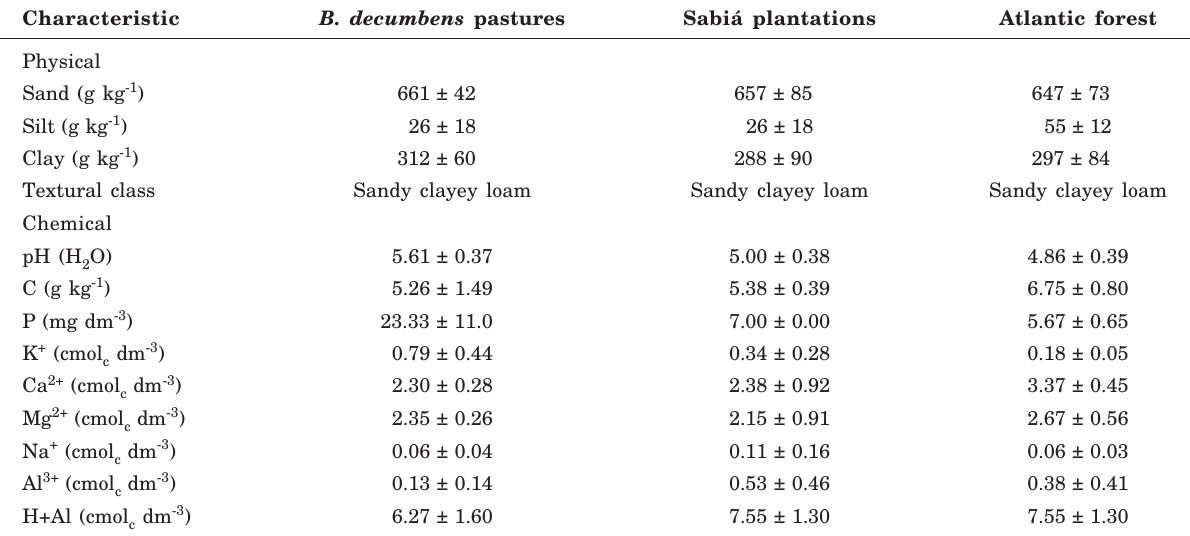
Table 1. Means and 95 % confidence intervals of the physical and chemical characteristics of samples of the 0-20 cm soil layer from areas of Brachiaria decumbens , sabiá woodlots and Atlantic Forest at the Itambé Experimental Station